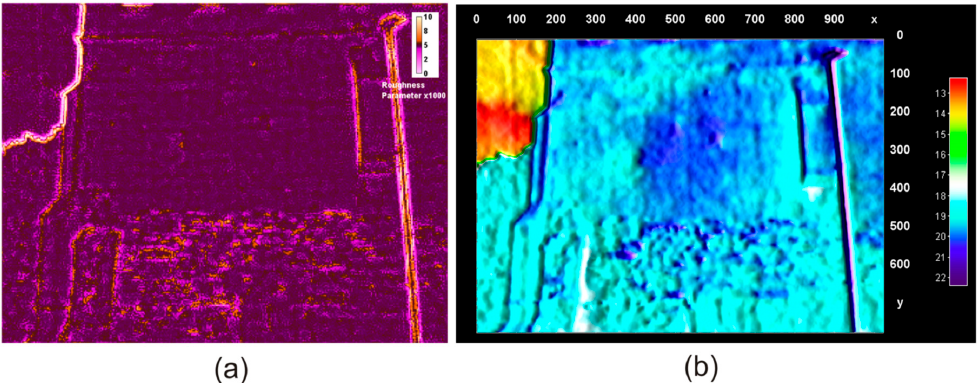
Figure 9. Kelham church, Nottinghamshire, U.K., the exterior north wall of the chancel: ( a ) surface thermal roughness using a Gaussian filter; ( b ) 3D plot of thermal values for comparison.